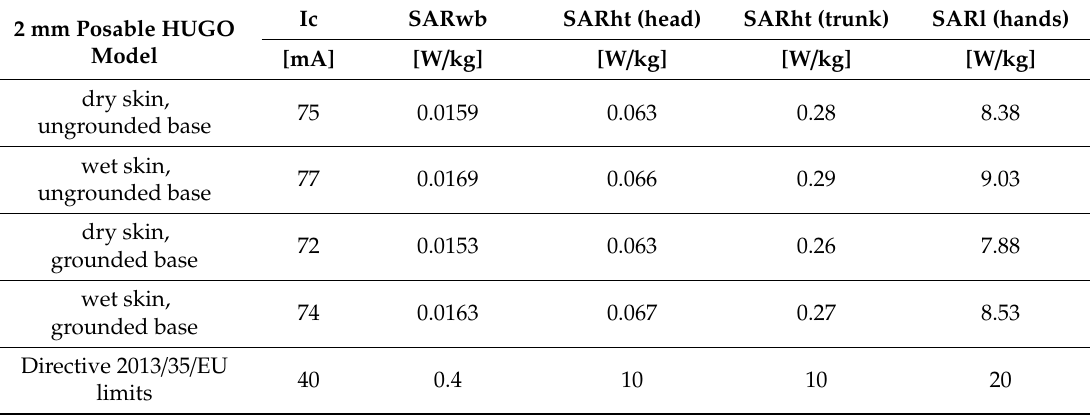
Table 3. The results of the SAR and limb currents numerical analysis when compared to the